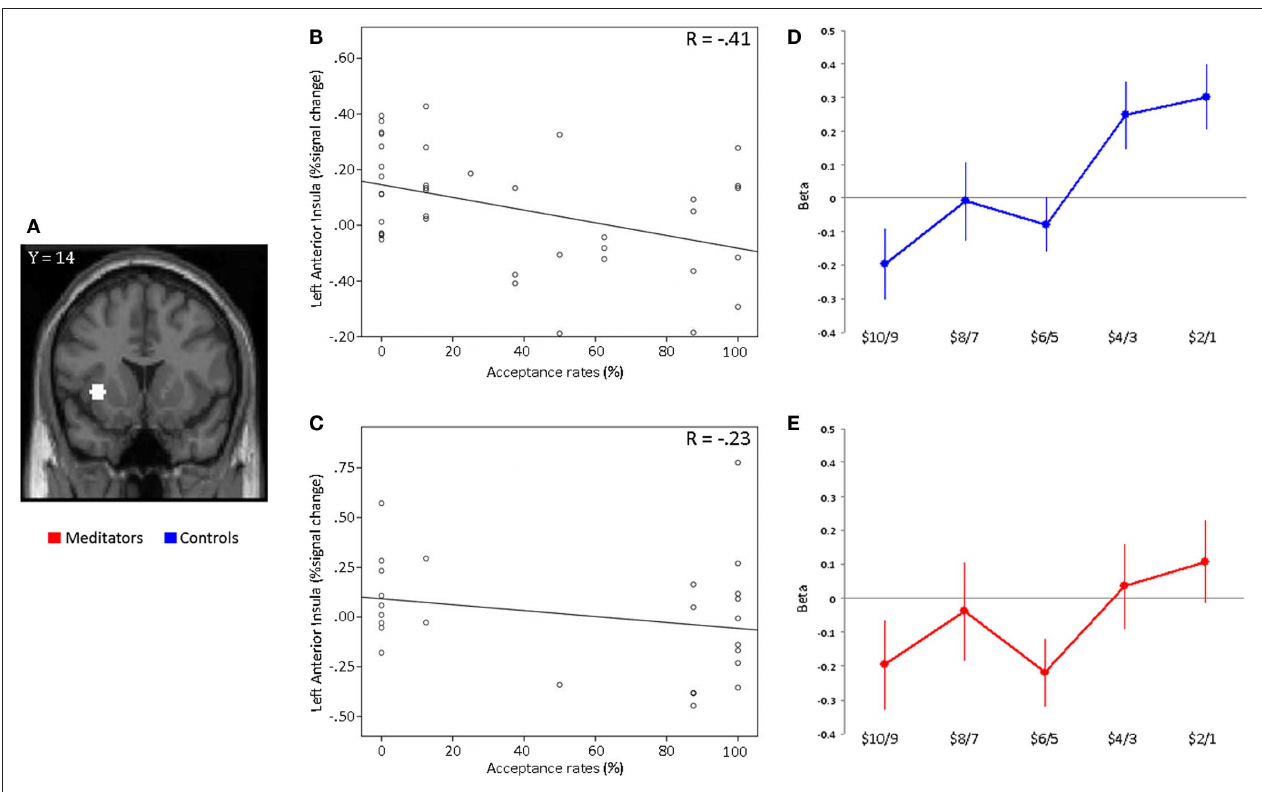
(R) is given in the plot. Each data point in the plot represents a subject. A similar correlation pattern was found for right anterior insula in both groups (not shown). (D) Controls display a significant difference between fair ($10:10–$14:6) and unfair ($19:1–$15:5) offers in the left anterior insula. (e) The meditator group shows no significant differences between fair and unfair responses in the left anterior insula.